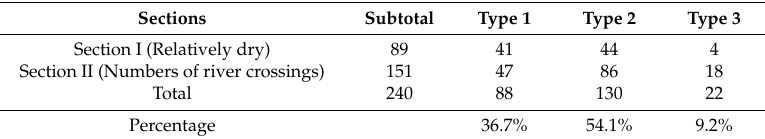
Table 2. Excavation results of two sections for FJC failure numbers.